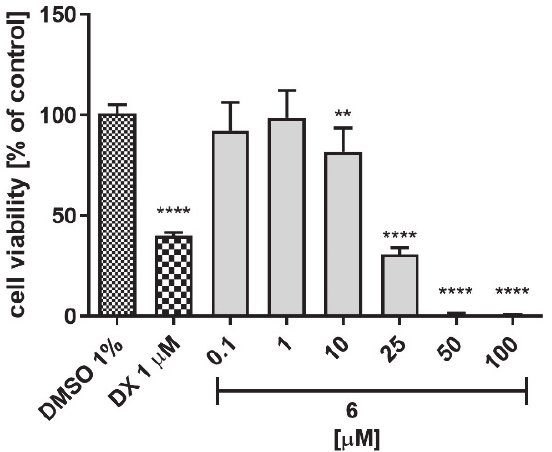
Figure 15. The influence of compound 6 and the reference cytostatic drug doxorubicin (DX) on the viability of hepatoma HepG2 cells after 72 h of incubation. DMSO was used as a control (1% in cell growth media). Statistical significance (**** p < 0.0001, ** p < 0.01) was analyzed by GraphPad Prism TM 6 software using a one ‐ way ANOVA and Bonferroni’s multiple comparisons post ‐ hoc test. The